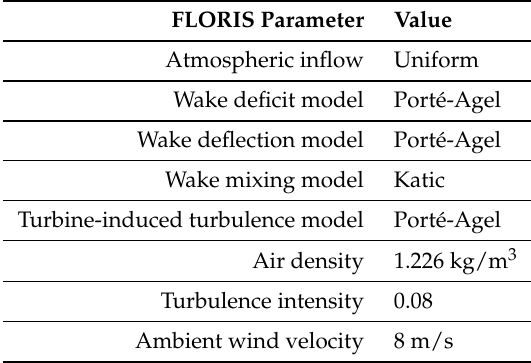
Table 2. FLORIS model settings and parameters used in the